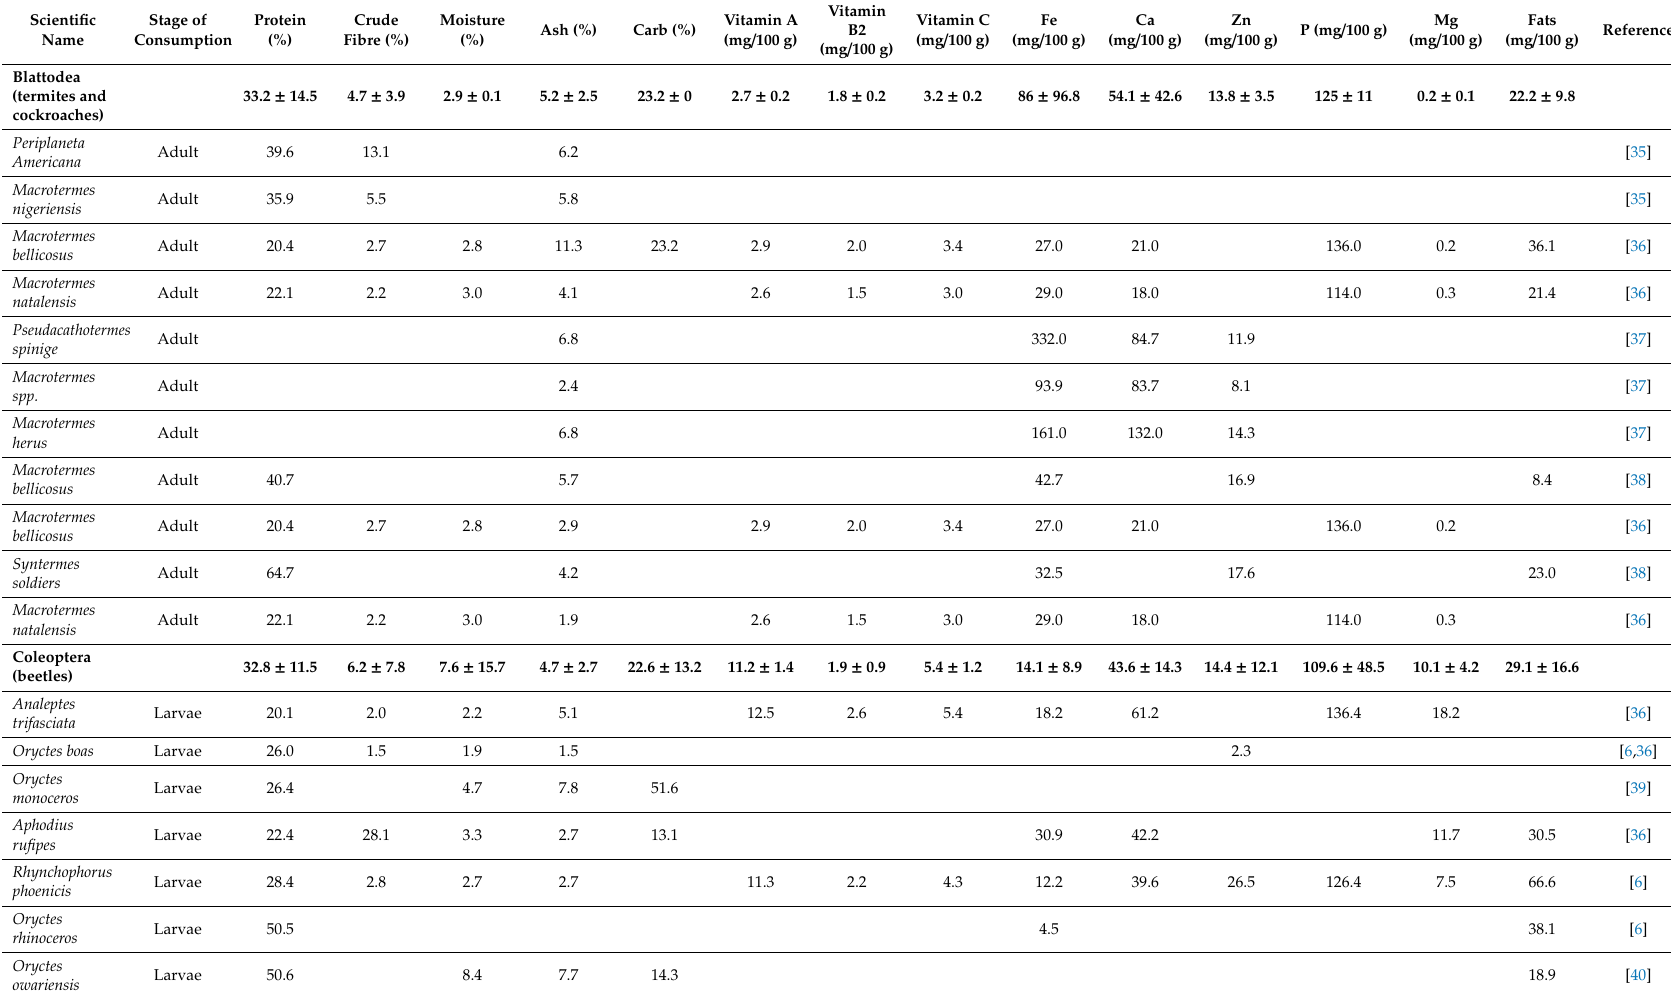
Table 1. Nutritional composition of edible insects, based on dry matter, from six orders consumed by people in